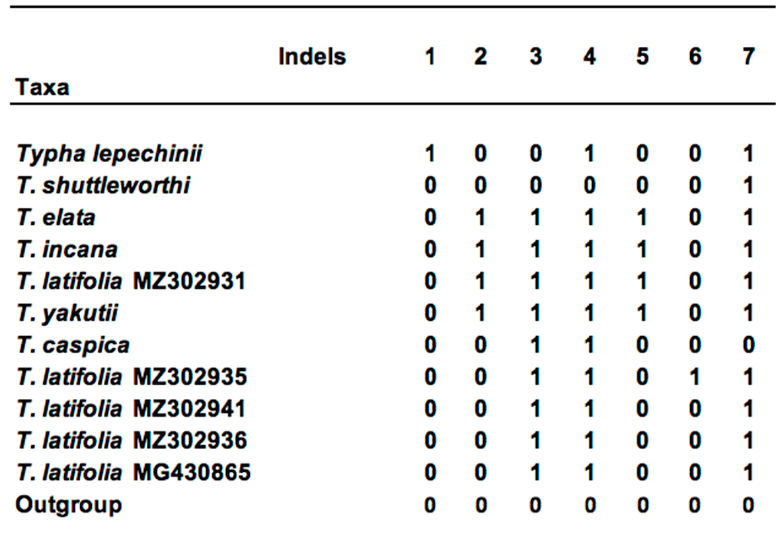
Figure 10. Similar to Figure 9, but simplified and established as a binary (“presence–absence”) matrix under the assumption that the presence of an indel is an apomorphic character state.